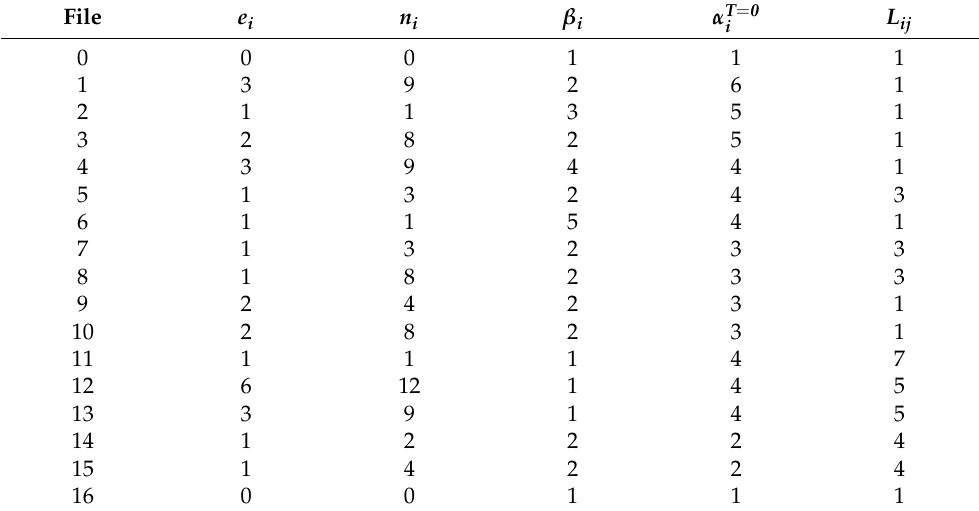
Table 1. Model parameters at T = 0